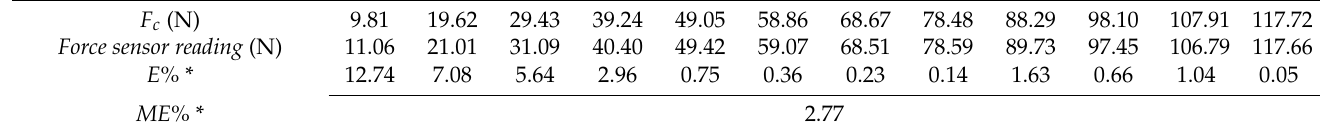
Table 6. The error test of the major cutting force